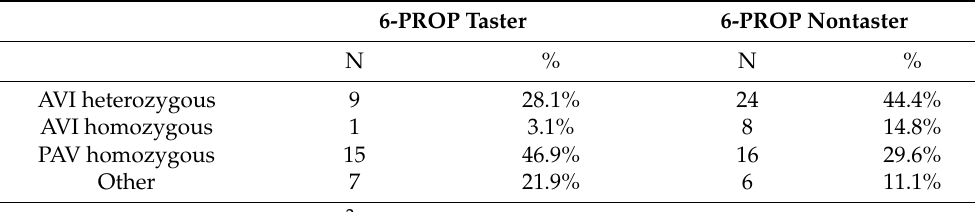
Table 9. Correlation between genotype and bitter taste perception to a